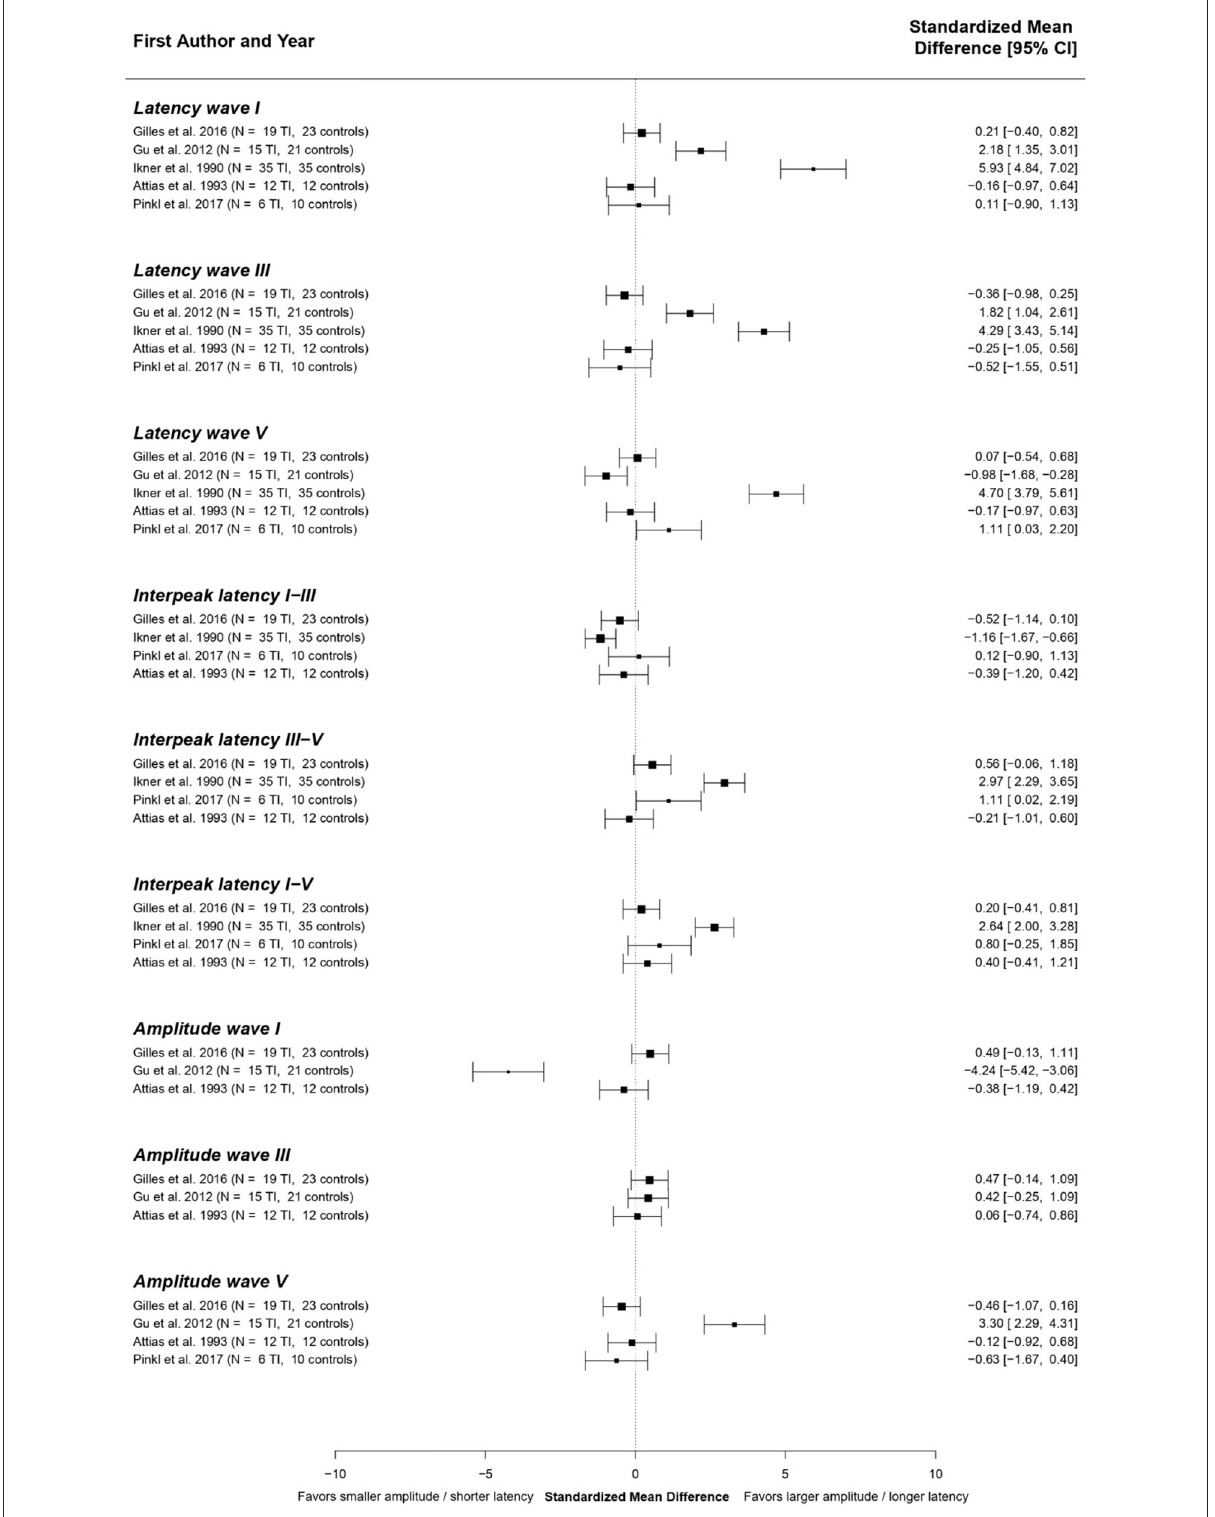
FIGURE3 Standardized mean differences for the different ABR components across studies comparing tinnitus patients with hearing loss to controls. The studies of Attias et al. (97) and Rosenhall et al. (98) could not be included in this analysis, since numerical results of different ABR components were not reported in these